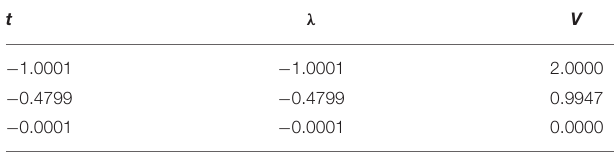
TABLE 1 | Numerical solutions for N = 1 at g = 0.01.